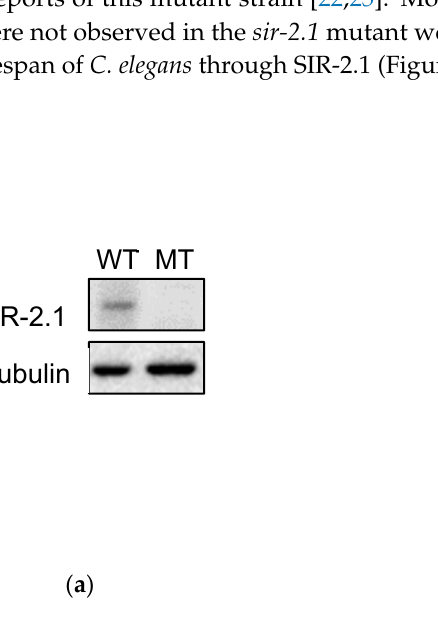
Figure 6. E ff ects of PEA and N-APEA in sir-2.1 mutant worms. ( a ) SIR-2.1 protein expression in wildtype (WT) and sir-2.1 mutant (MT) nematodes. ( b ) The graph displays the mean ± SEM of three independent experiments, and each group in the experiment consisted of 50 worms. The control is the group of untreated sir-2.1 mutant worms. Differences relative to the control were considered significant at * p < 0.05 and ** p < 0.01.